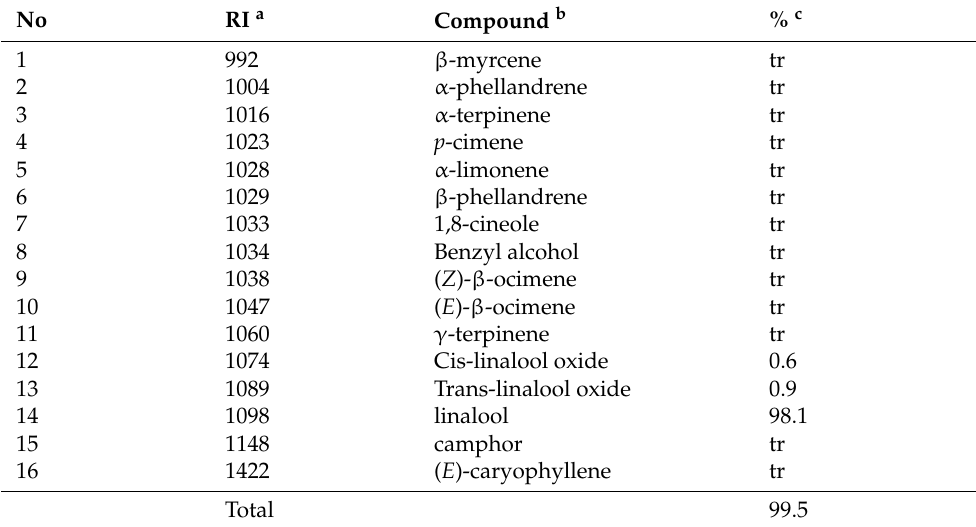
Table 1. Chemical composition of essential oil from Cinnamomum caphora var. Linalolifera .